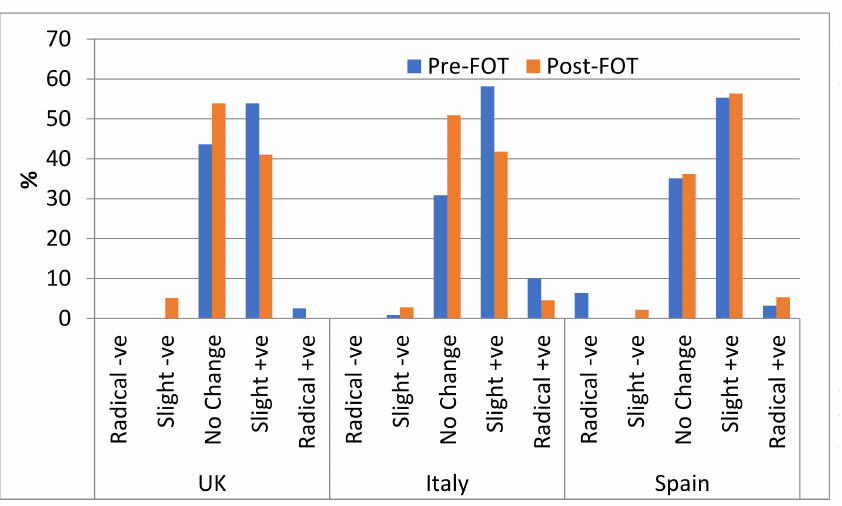
Figure 2. Speed Information/Alert: perception of safety pre- and